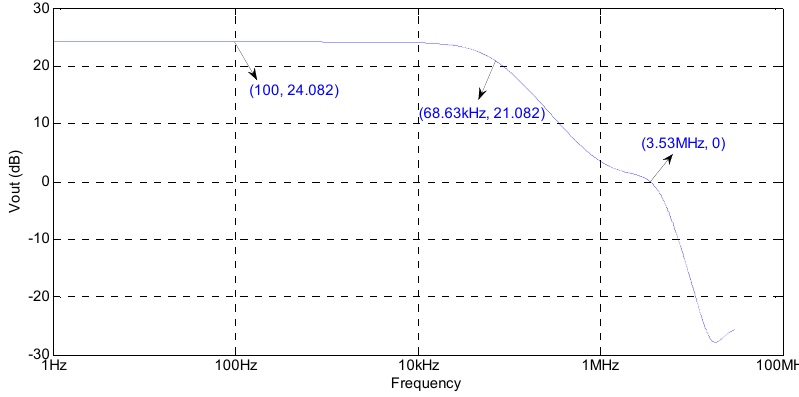
Figure 11. Simulated frequency response of the power amplifier.